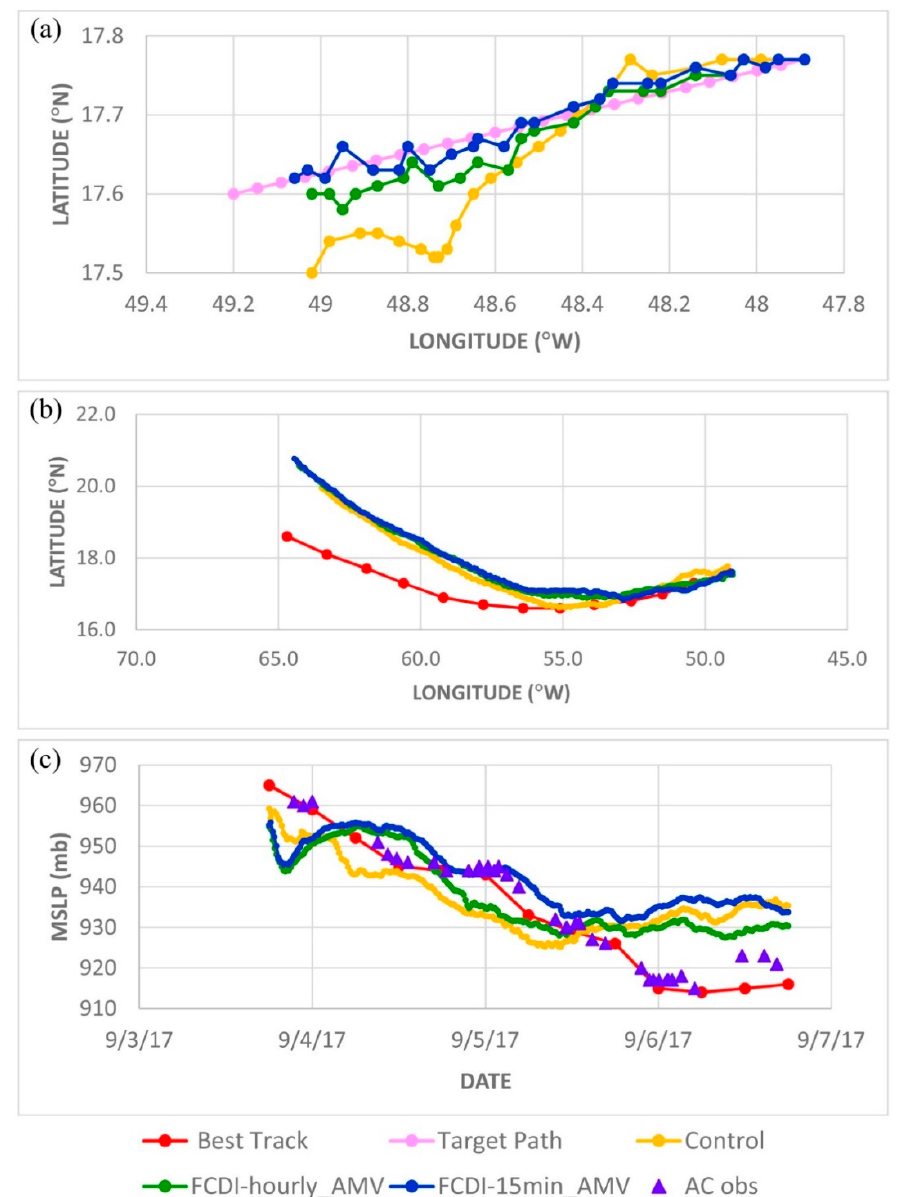
Figure 10. ( a ) Six-hour FCDI surface wind adjustment target path each 15 min (pink dots) starting from 17.77 ◦ N, 47.9 ◦ W position at 12 UTC 3 September and ending at Irma best-track position 17.6 ◦ N, 49.2 ◦ W at 18 UTC 3 September, and then corresponding 15 min positions for six-hour Control COAMPS-TC forecast (gold dots) and for FCDI vortex positions based on 15 min AMVs (blue dots) and based on hourly AMVs (green dots). ( b ) Irma best-track positions each six hours from 18 UTC 3 September to the 18 UTC 6 September ending at 18.6 ◦ N, 64.7 ◦ W compared to COAMPS-TC forecast positions of Control (19.95 ◦ N, 63.48 ◦ W, gold dots), 15 min AMV FCDI at 20.76 ◦ N, 64.44 ◦ W (blue dots), and hourly AMV FCDI at 20.57 ◦ N, 64.29 ◦ W, green dots). ( c ) Irma best-track MSLP (mb) each 6 h (red dots) starting from 18 UTC 3 September to 18 UTC 6 September compared with COAMPS-TC MSLP forecast at 15 min intervals by Control (gold dots), 15 min AMV FCDI (blue dots) and hourly AMV FCDI (green dots). Note that NOAA and Air Force aircraft MSLP observations are indicated by purple triangles.